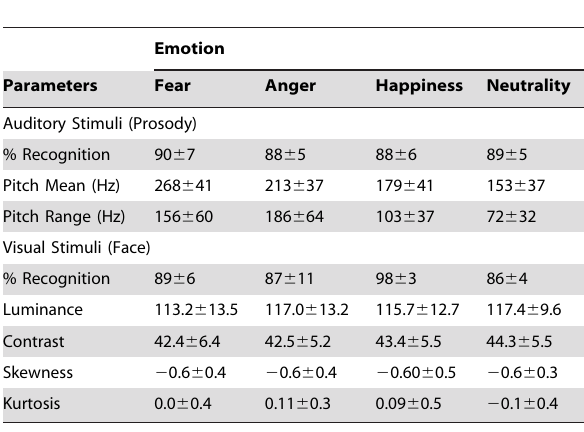
Table 1. Major perceptual and physical parameters of the emotional stimuli presented in the